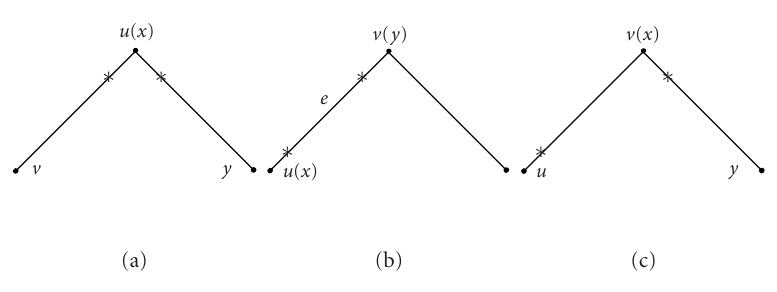
Figure 1.2. Cases of two arcs (incidences) are